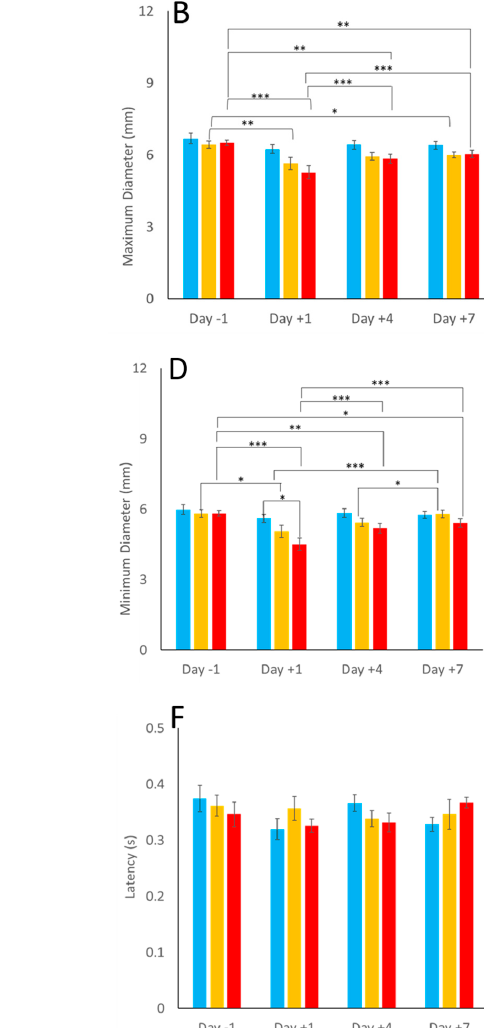
Figure 3. Proportion of validation and experimental animals in the healthy reference range ( A , C , E ) and two-way repeated-measure ANOVA results for the effect of injury group and study day ( B , D , F ) for maximum diameter ( top row ), minimum diameter ( middle row ), and latency ( bottom row ). Blue bars represents sham, yellow bars represents sRNR, and red bars represents rRNR groups. The healthy RR is demarcated with green dotted lines in ( A , C , E ). Overlaying cross bars show significant comparisons with * p < 0.05, ** p < 0.01, and *** p < 0.001.